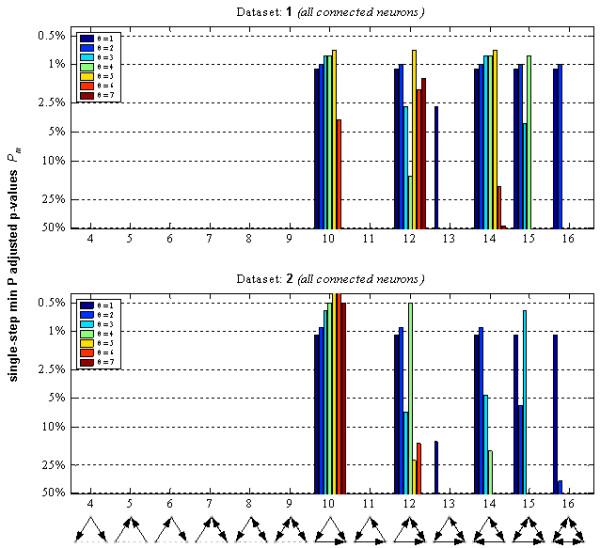
Significance measure Pm of triplet over-representation for different thresholds. The multiple hypothesis testing corrected p-values for triplet patterns show significant over-representation of patterns 10, 12 and 14 (datasets 1 and 2, n = 1000). The significance measure Pm represent the probability of finding a random matrix R, in which at least one class has smaller (or equal) raw p-value than that found for a given class in the actual network.